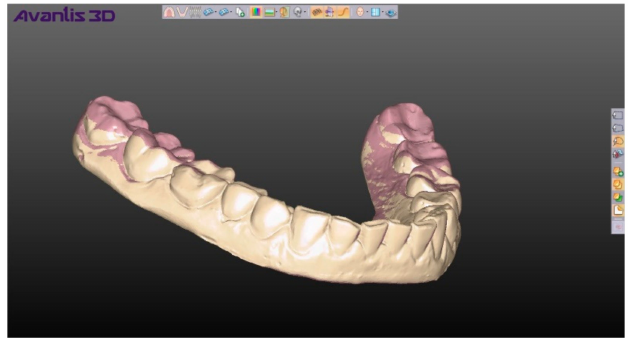
Figure 3. Position of centric relation of the jaws in Avantis 3D program.